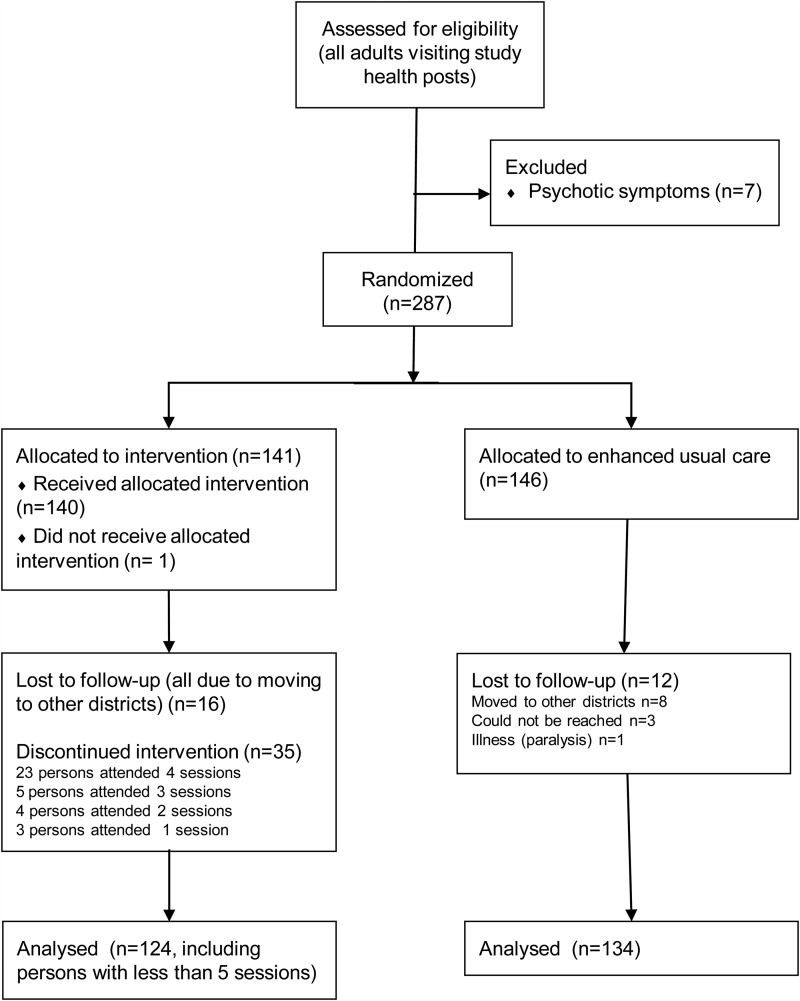
Flow chart of study participation.